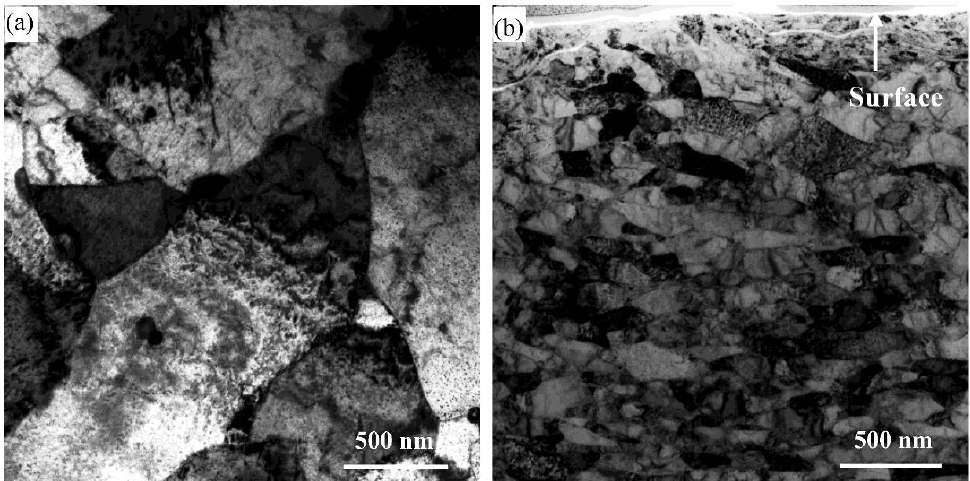
Figure 1. Cross-sectional bright field TEM image of the reduced activation steel ( a ) before and ( b ) after surface mechanical attrition treatment (SMAT).